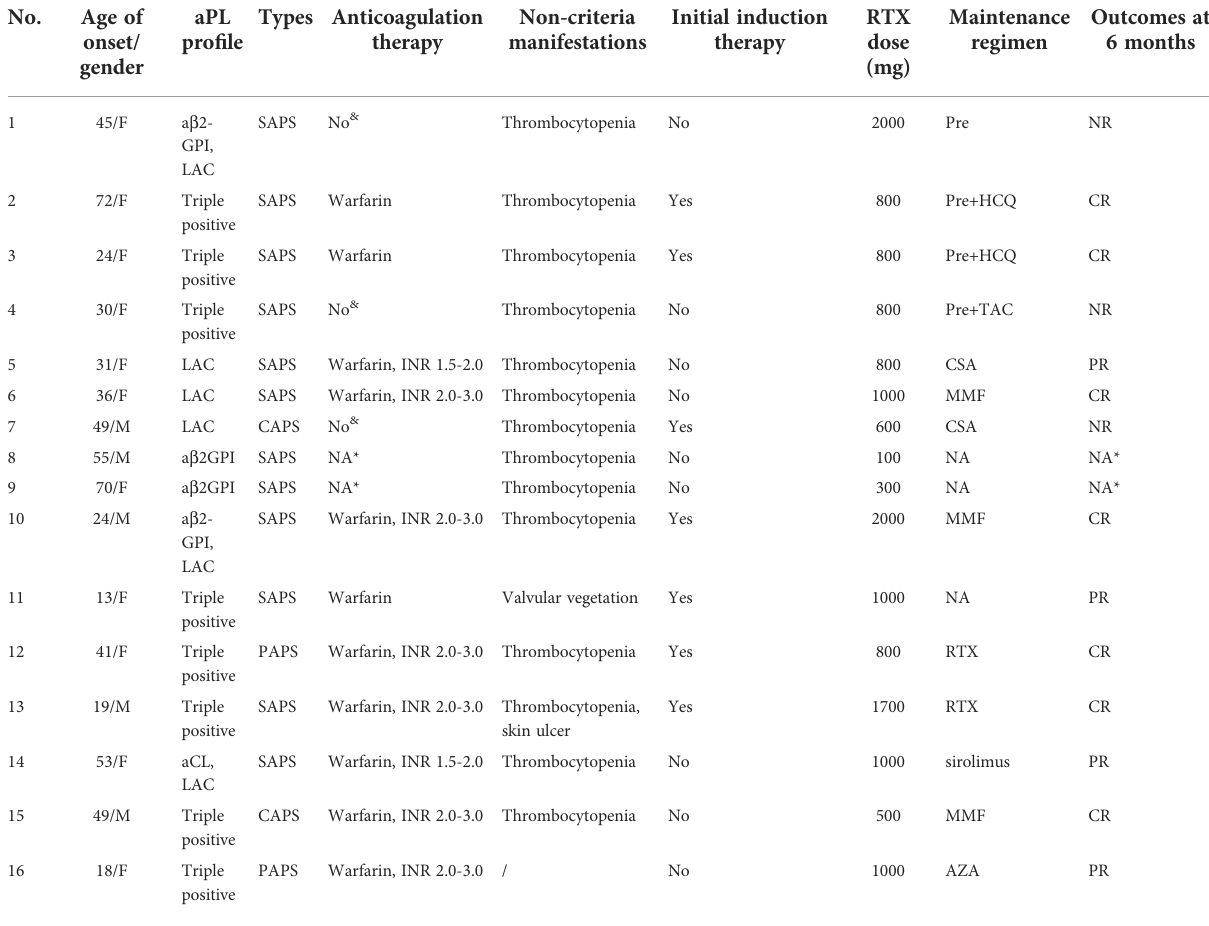
TABLE 1 Detailed clinical pro fi les of APS patients with